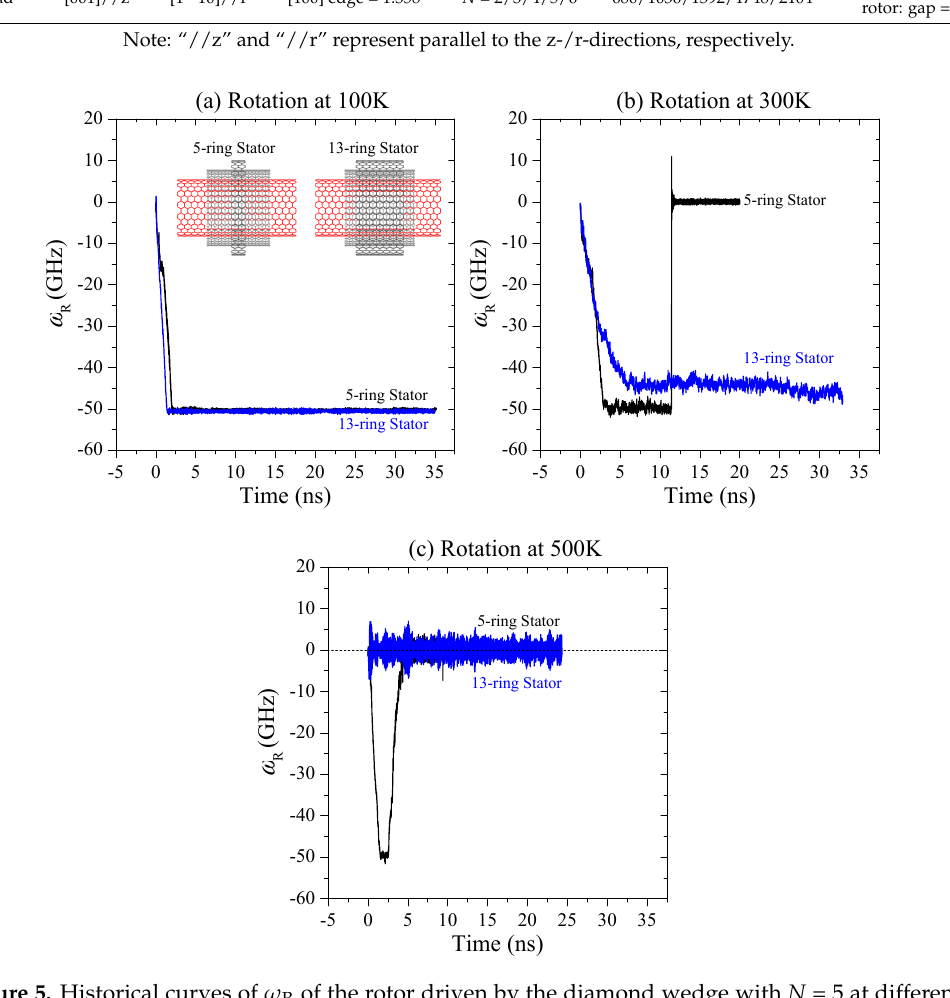
Figure 5. Historical curves of ω R of the rotor driven by the diamond wedge with N = 5 at different temperatures. ( a ) Rotational frequency of rotor at 100 K, ( b ) at 300 K, and ( c ) at 500 K.